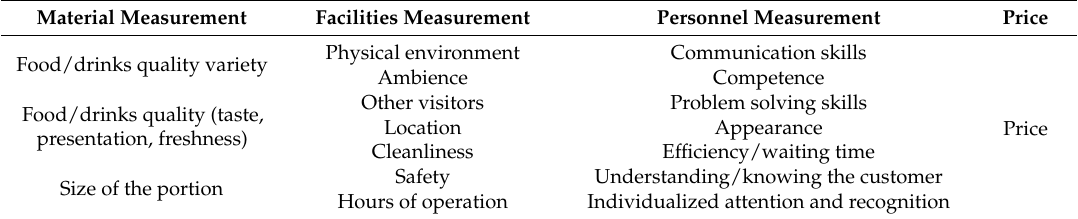
Table 1. Food Quality